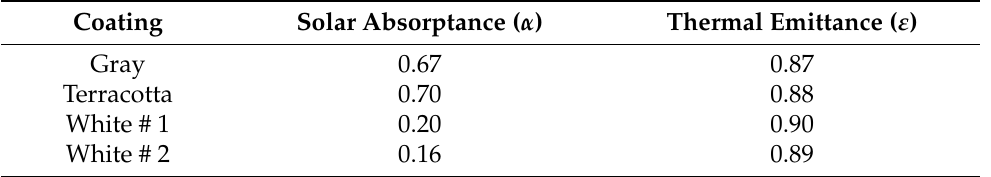
Table 2. Optical properties of the